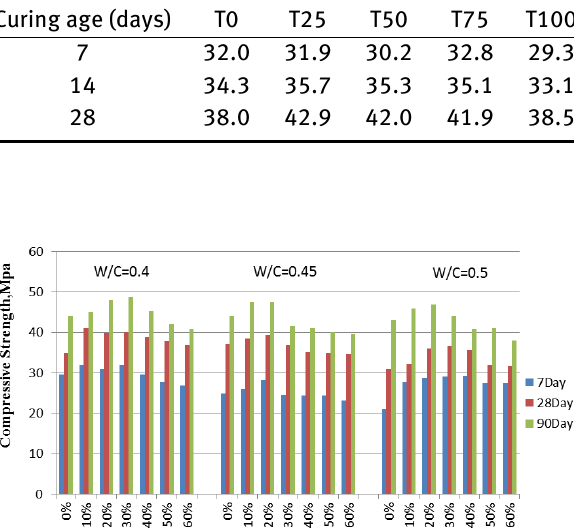
Figure 8: Pore size distribution of mortar containing iron ore tail- ings [28]